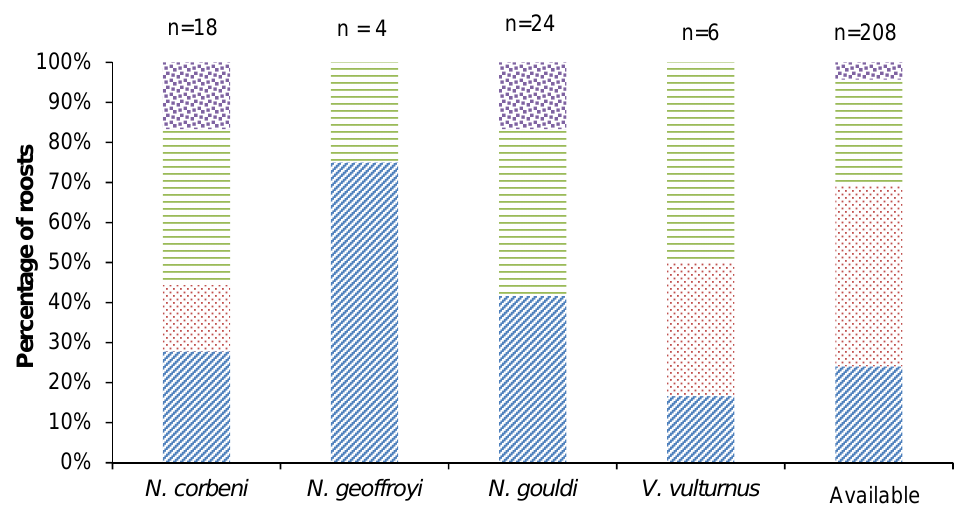
Figure 2. Percentage of roost trees of each species that were represented by buloke, cypress, eucalypts and other trees (2016 and 2017) plus their local availability in the proximity of roost trees. For all species, ≥ 50% of all roosts were located in a hollow or a fissure (Figure 3). Nyctophilus corbeni and N. gouldi also roosted under bark (Figure 3). Vespadelus vulturnus roosts were exclusively in hollows (Figure 3).